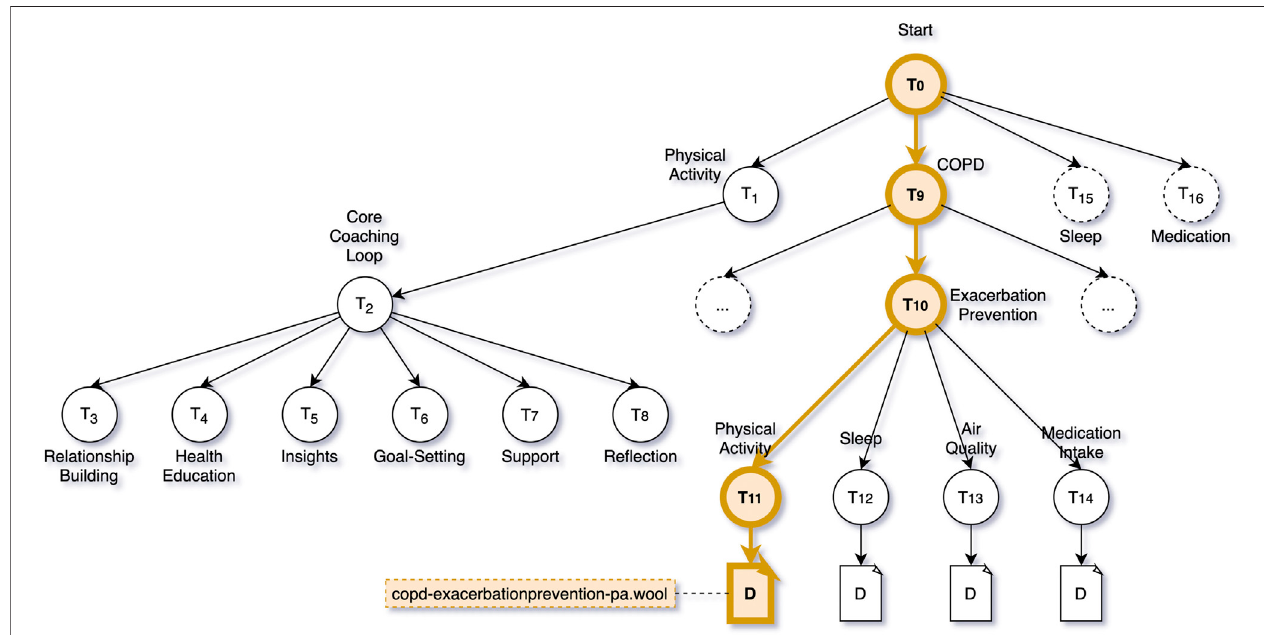
FIGURE 8 | COPD Intervention Topic Structure — Highlighted the decision path to trigger the dialogue script